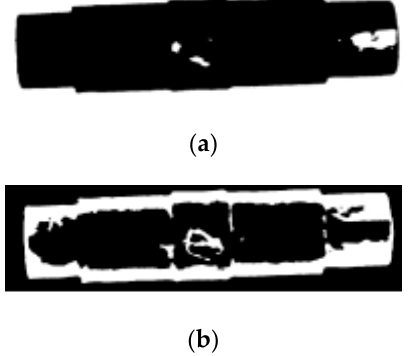
Figure 7. Comparison of two threshold methods. ( a ) Otsu threshold method; ( b ) Adaptive threshold method.